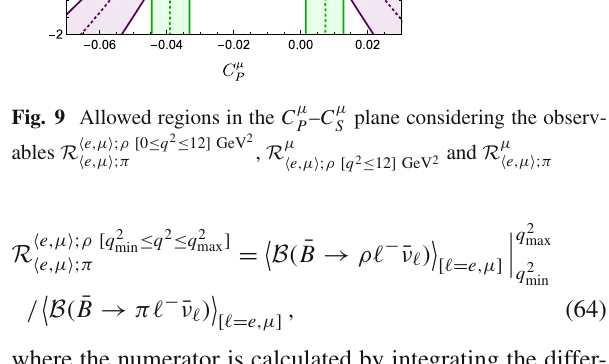
Fig. 9 Allowed regions in the C